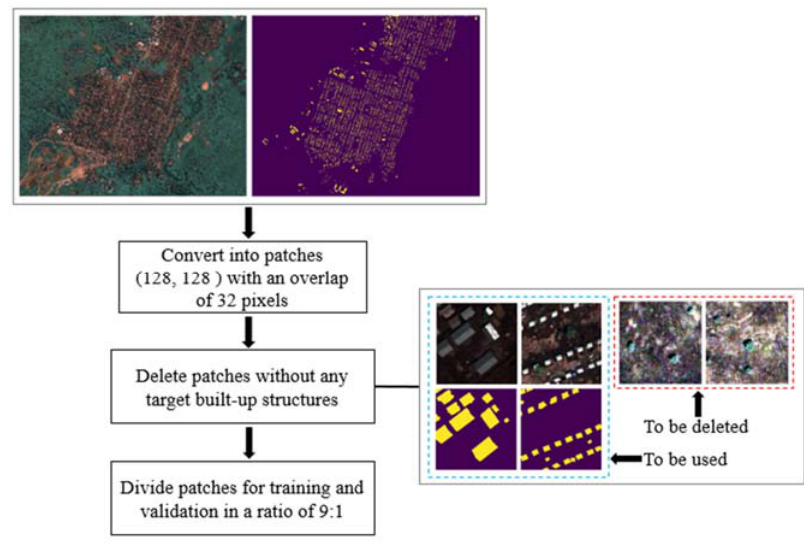
Figure 3. The examples of the OBIA labels and the Manual labels of built ‐ up structures in the Kule and Nguenyyiel refugee camps during the dry and the wet seasons.